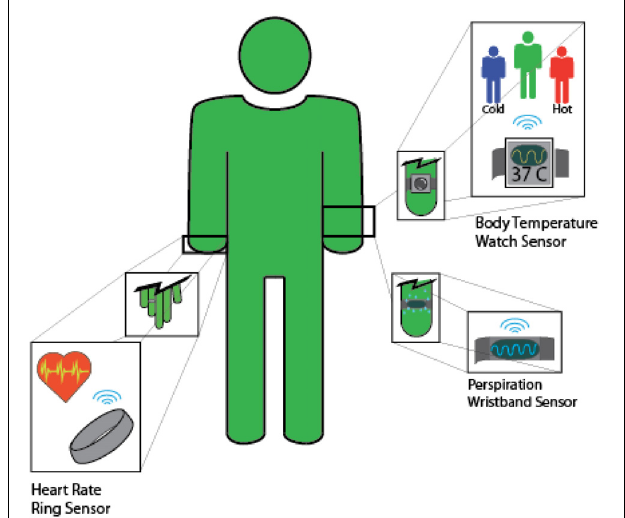
FIGURE 9 | The use of wearable sensors as a means of non-intrusive collection of personalized data.